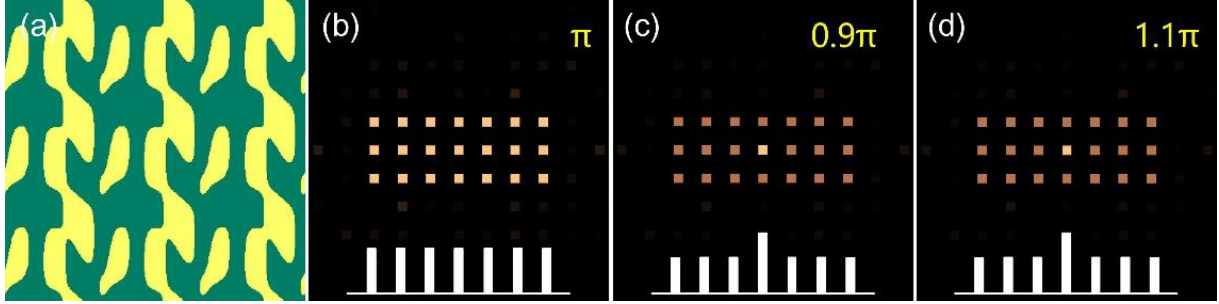
Figure 1. ( a ) Phase distribution of the calculated binary diffractive optical element (DOE) and the reconstructed intensity distribution with phase difference of ( b ) π, ( c ) 0.9π, ( d ) 1.1π.